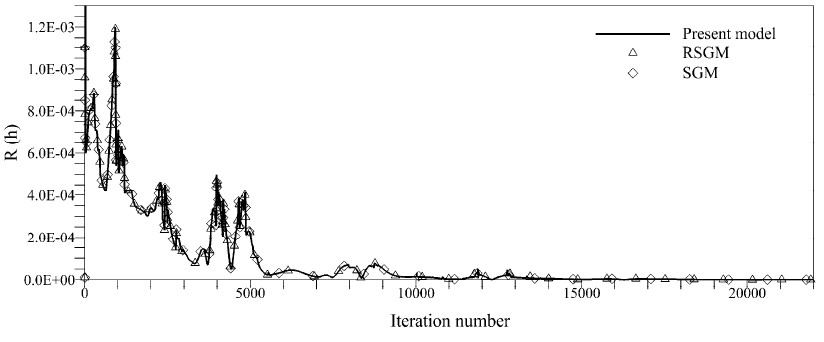
Figure 11. Relative error measurement for transcritical flow with shock. Table 1. L 1 error-norm for flow variables over a